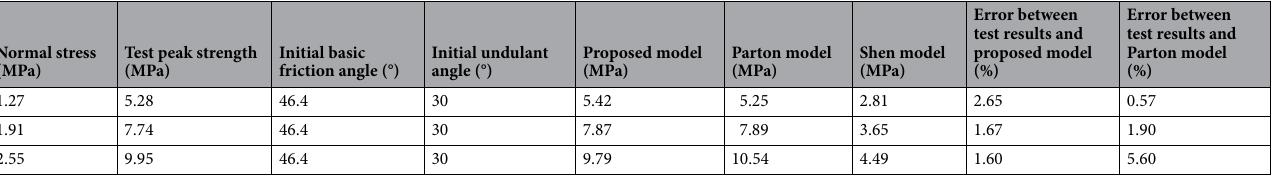
Table 5. Comparison between the shear stress calculation